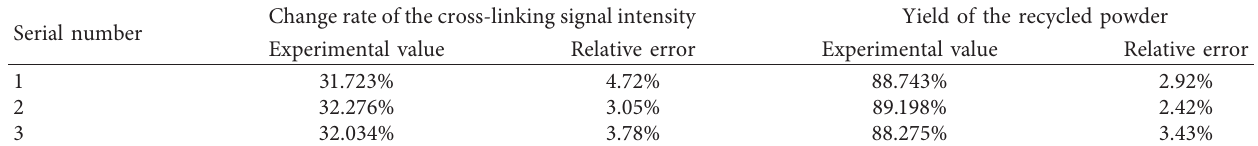
Table 6: Experimental verification